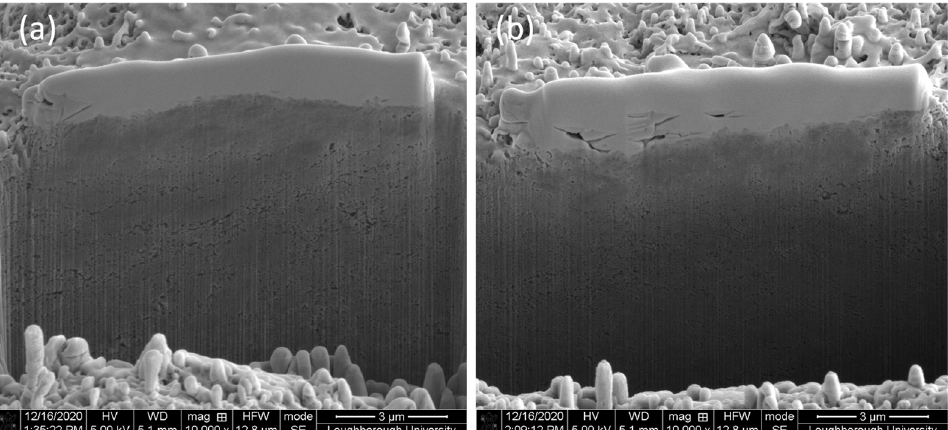
Figure 12. SEM images showing a slice milled through the CNT coating: ( a ) condition A, ( b ) condi- tion G. All images were taken with a sample tilt of 50°.